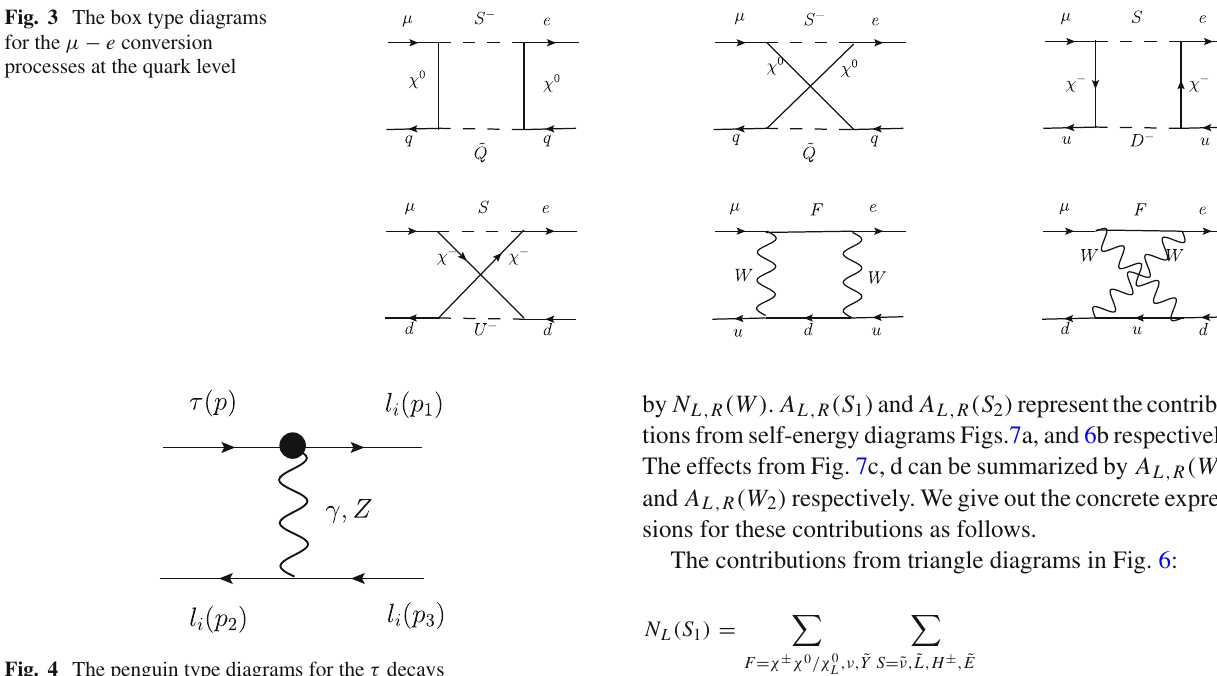
Fig. 4 The penguin type diagrams for the τ decays